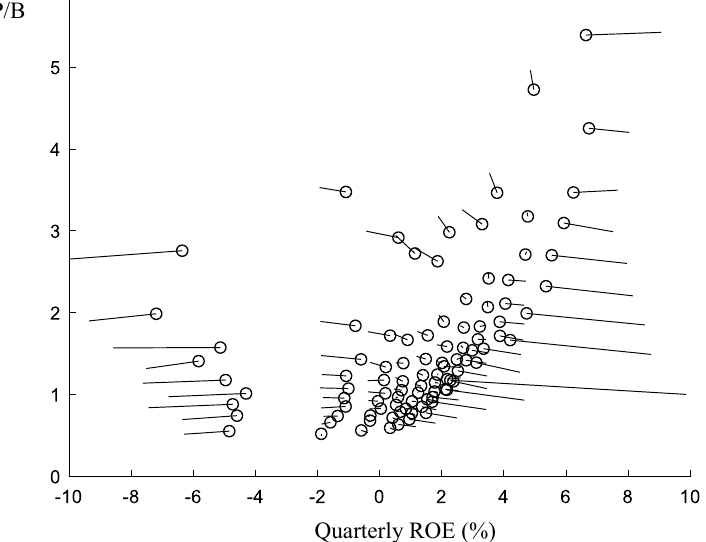
Fig. 4 The ROE and P/B ratio for the current quarter and the subsequent first quarter after the portfolios are